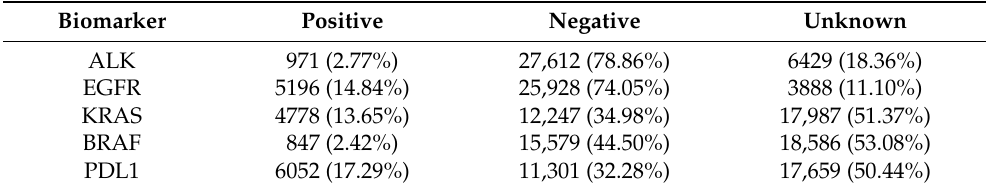
Table 1. Status of biomarkers for the population cohort of NSCLC patients followed-up for the present